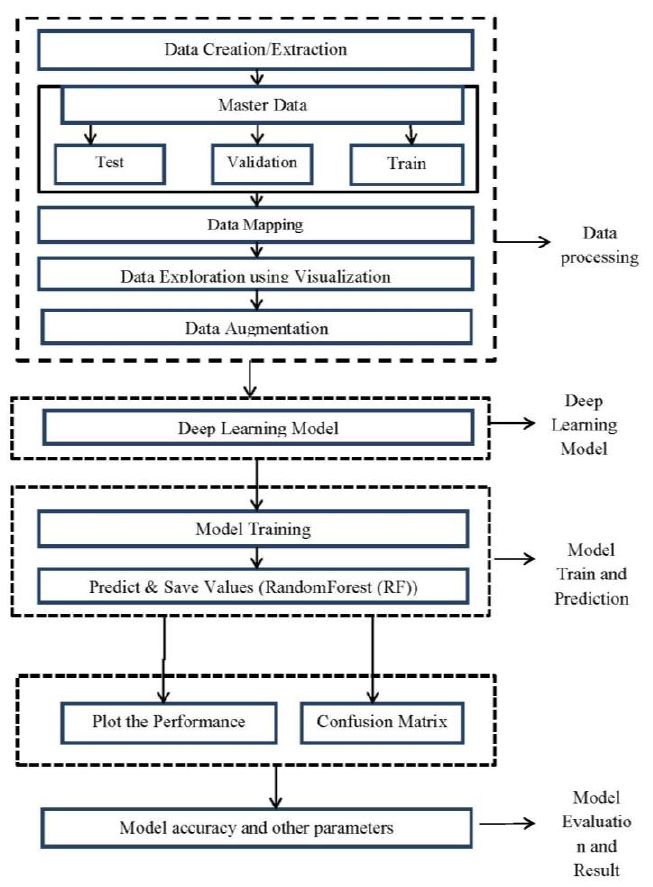
Figure 1. The flow chart for the proposed methodology.